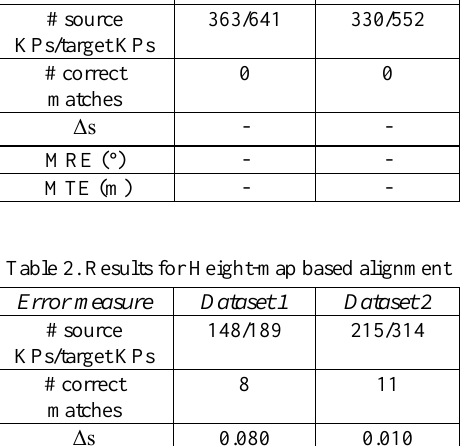
Table 1. Results for 3D-based alignment